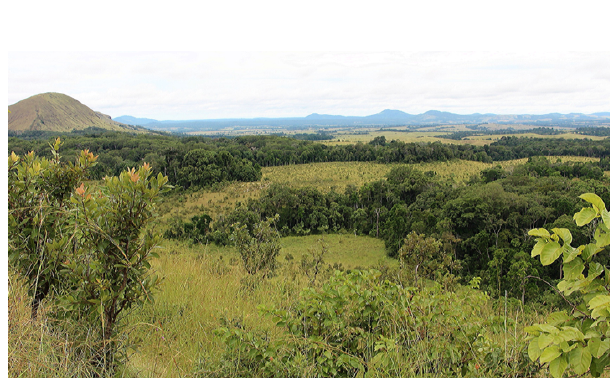
Figure 4. Hydrologic stations are currently being installed and up- graded in the vast and understudied central African landscapes. The international French critical zone program, OZCAR, is expand- ing biogeoscience infrastructure in the Congo River basin and in smaller river basins such as Gabon’s Ogooué River. The image is of Gabonese savannas and forests in Lopé National Park (photograph, Jean Jacques